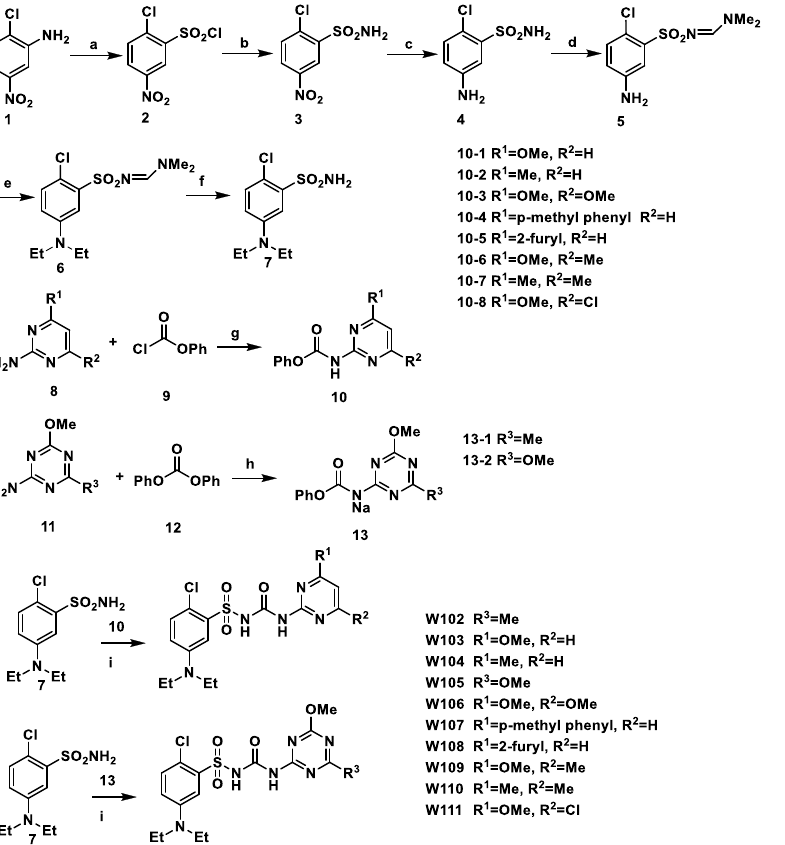
Figure 3. The synthesis of compounds W102 – W111 . Reagents and conditions: (a) H 2 O, HCl, NaNO 2 → H 2 O, HCl, CuCl 2 , NaHSO 3 , −5 °C; (b) 28% NH 3 ·H 2 O, THF, 0 °C → RT (room temperature), overnight; (c) Fe, HCl, C 2 H 5 OH, H 2 O, reflux; (d) DMF-DMA ( N , N -dimethylformamide dimethyl acetal), CH 2 Cl 2 ; (e) IC 2 H 5 , K 2 CO 3 , DMF, 65 °C; (f) 80% H 2 NNH 2 •H 2 O, C 2 H 5 OH; (g) KI, K 2 CO 3 , THF, 0 °C → RT; (h) 60% NaH, THF, 0 °C → RT; (i) DBU (1,8-diazabicyclo[5.4.0]undec-7-ene), CH 3 CN. Intermediate 13 (1.90 mmol) and 12 (2.00 mmol), DBU (2.85 mmol) and 10 mL of